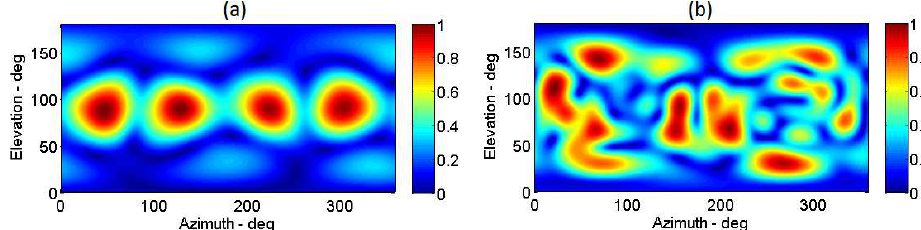
Figure 13. Normalized amplitude PWE at 63 Hz ( a ) and 250 Hz ( b ), regularized β = 0.33,